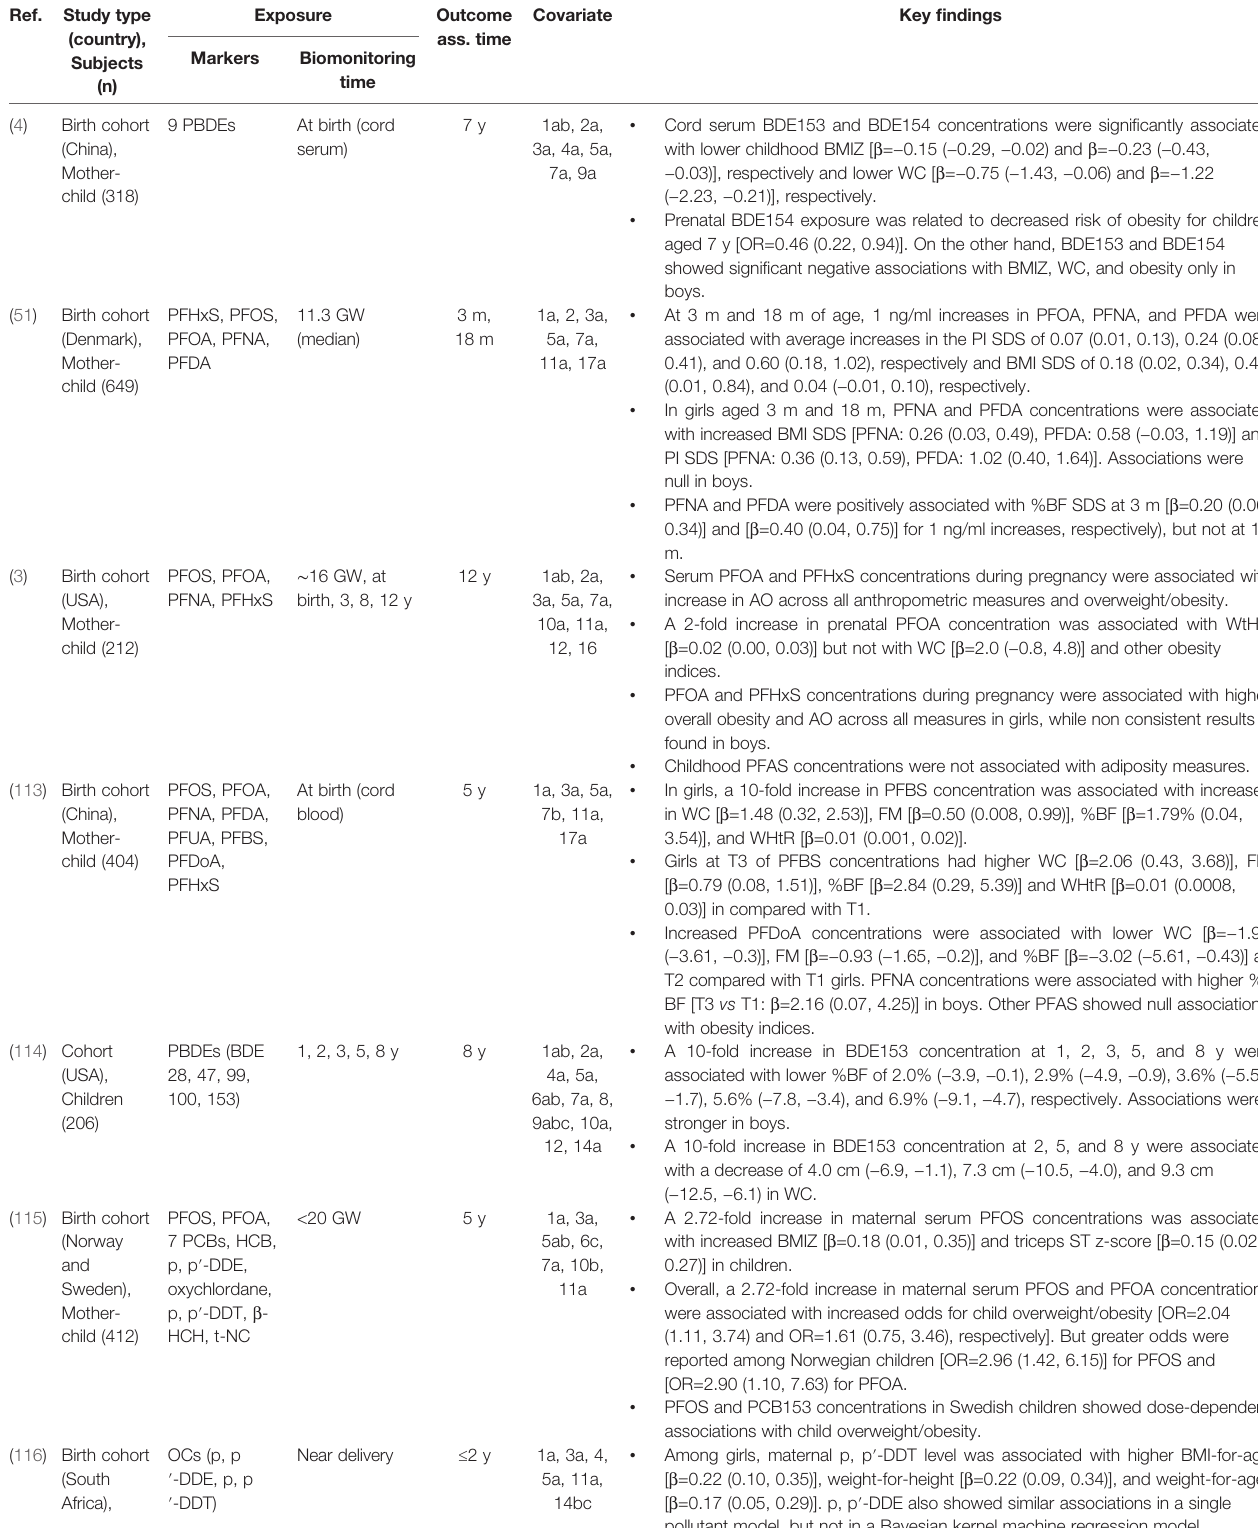
TABLE 3 | Associations of environmental persistent organic pollutants with anthropometric overweight and obesity indices. Ref. Study type